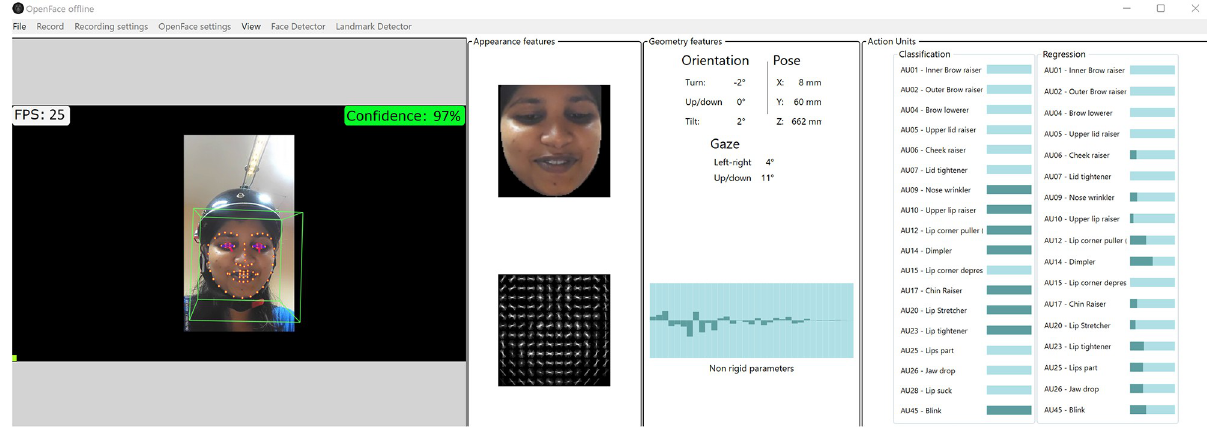
Fig 5. User interface of the OpenFace 2.0 program. Based on video and image outputs, this program detects and extracts participant facial features such as facial landmarks, head pose, eye gaze, and facial Aus.